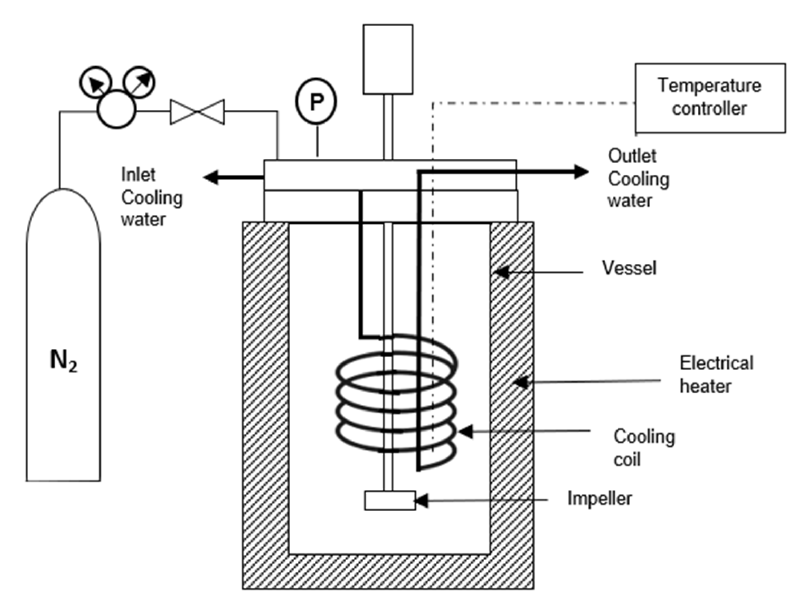
Figure 1. Schematic diagram of the 1 L hydrothermal carbonization reactor. Table 1. Overall sewage sludge HTC experimental plan. Temperature ( ◦ C) Solid Loads (wt.%) Reaction Time